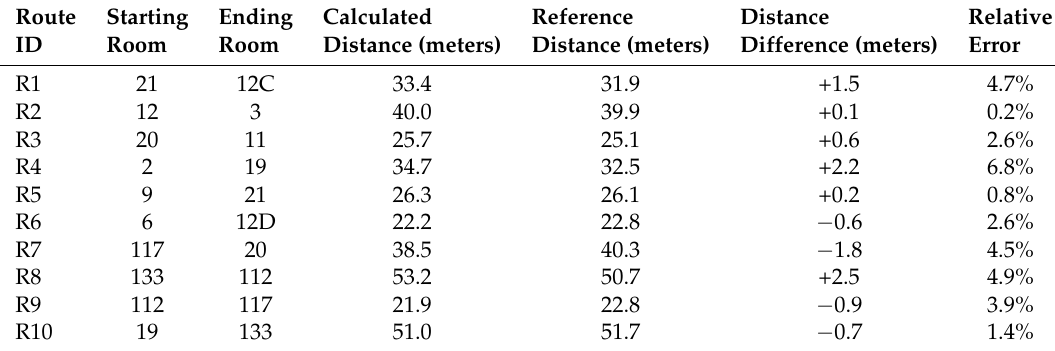
Table 1. Calculated results for Case 1 (R,